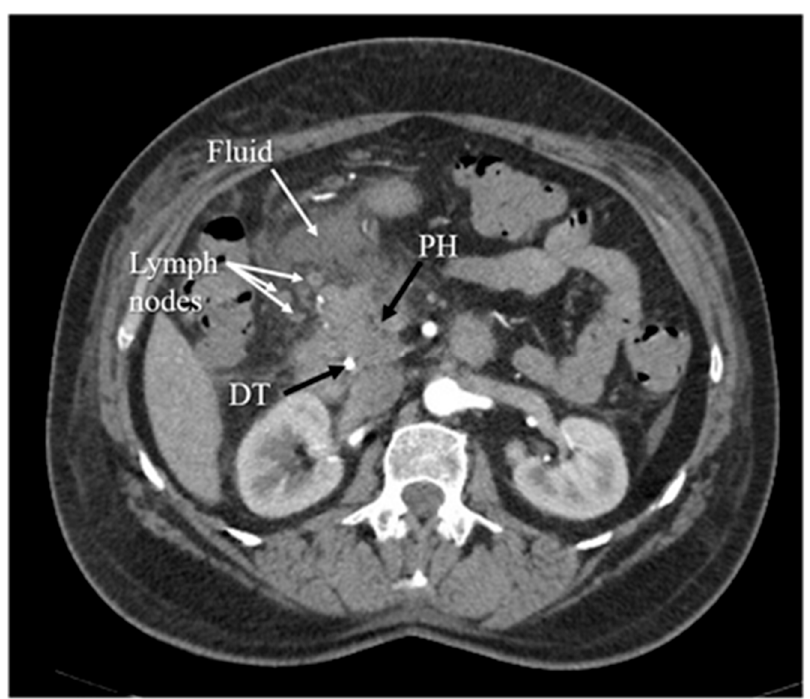
Figure 3. Early phase of the acute pancreatitis with stranding of surrounding fat (FS) and single, enlarged lymph node. The arterial phase of CT. PH—head of the pancreas.